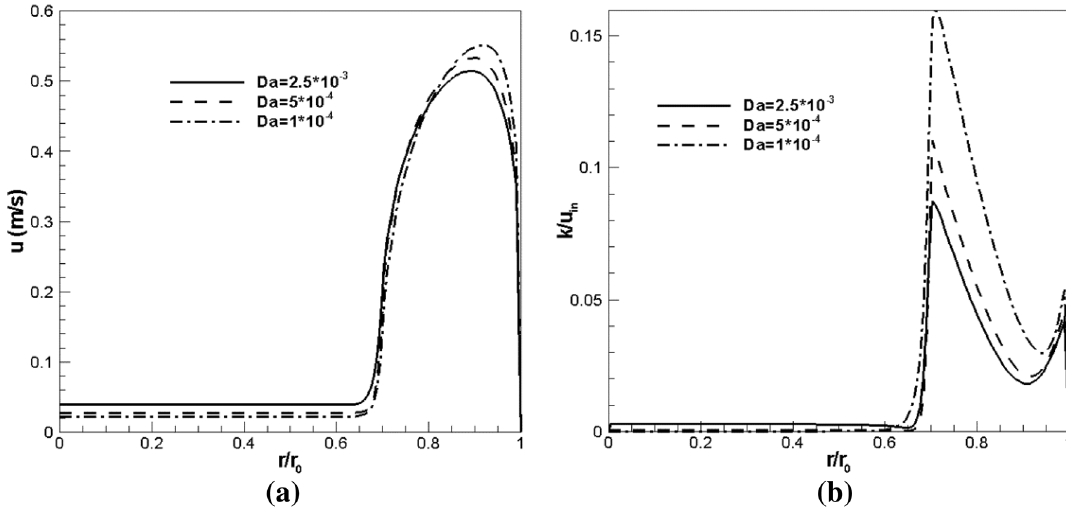
Fig. 6 Variation of a velocity, b TKE with Da in central